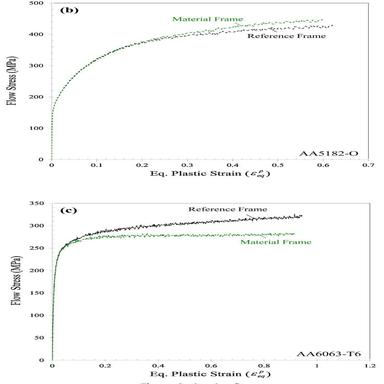
9. (continued)